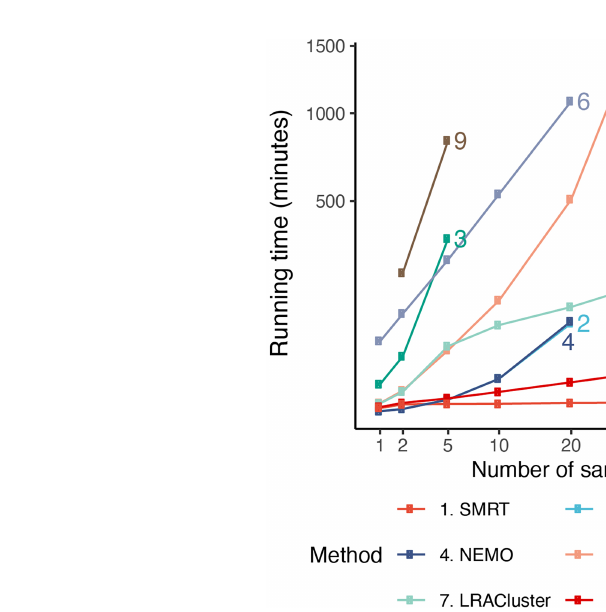
FIGURE 5 | Running time of the nine subtyping methods with respect to varying numbers of samples and features. SMRT is the only method that can analyze all datasets. Even for large datasets with 100,000 samples, SMRT needs only a couple of minutes to fi nish the